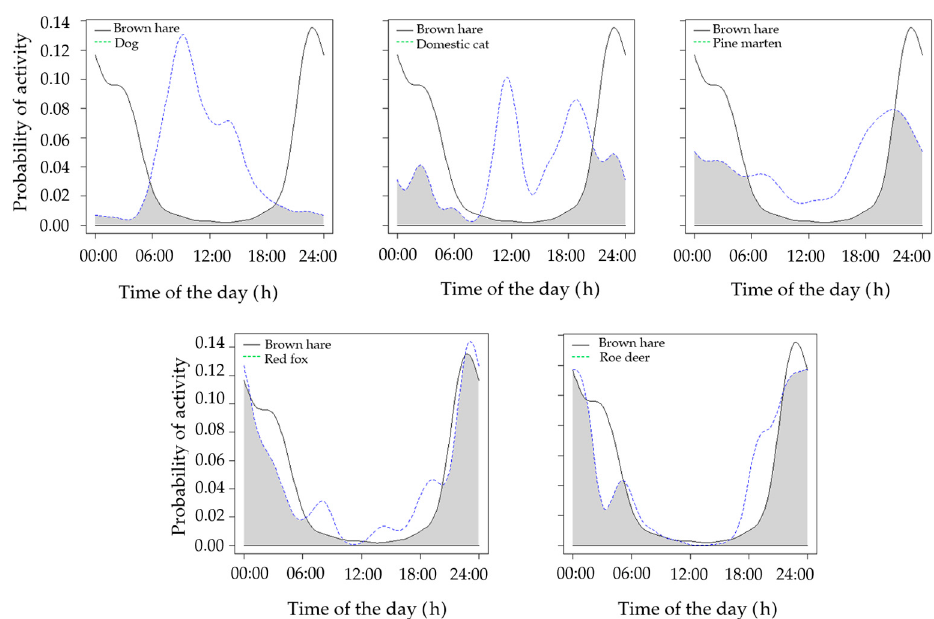
Figure 3. Annual overlap of activity rhythms between the brown hare and its potential terrestrial predators and competitors.